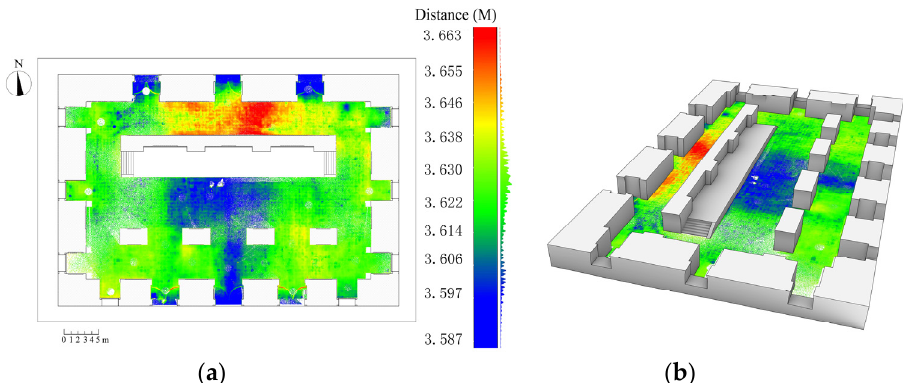
Figure 4. Ground subsidence analysis of the beamless hall of Linggu Temple. ( a ) Two-dimensional (2D) and ( b ) three-dimensional (3D) expression of subsidence